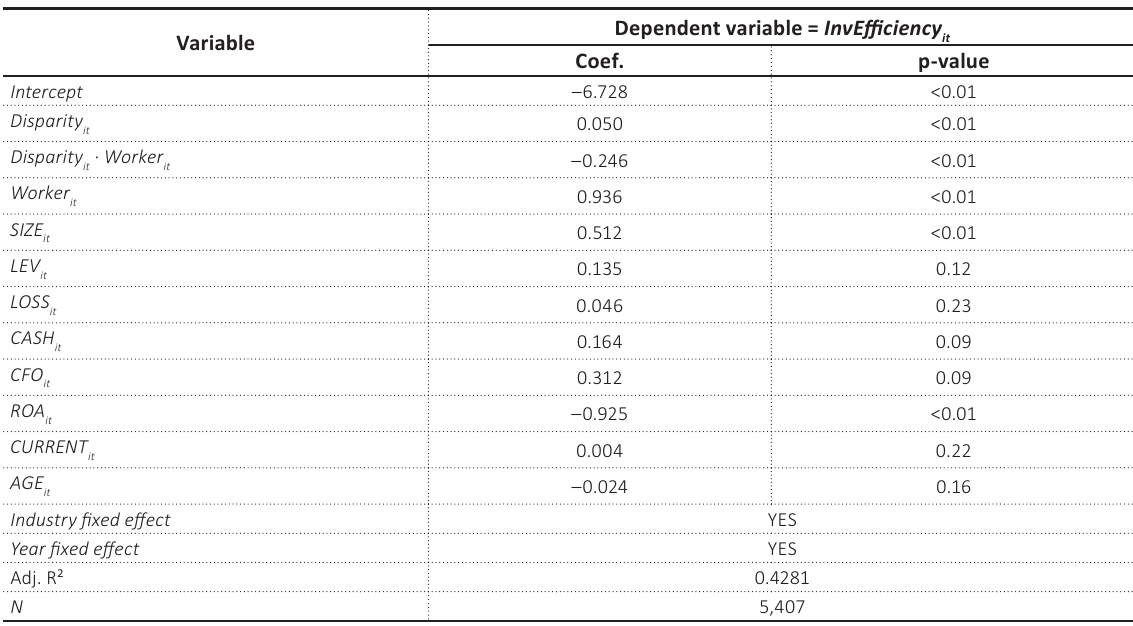
Table 4. Role of human resource investment in IC on the association between pay disparity and investment